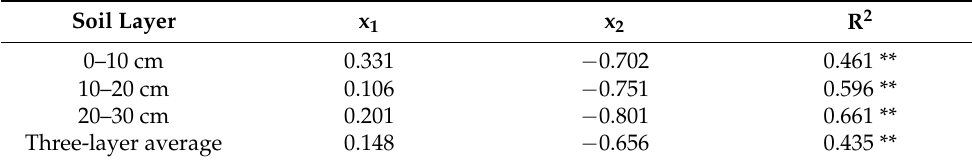
Table 9. Standardized coefficients of contribution equation for each soil